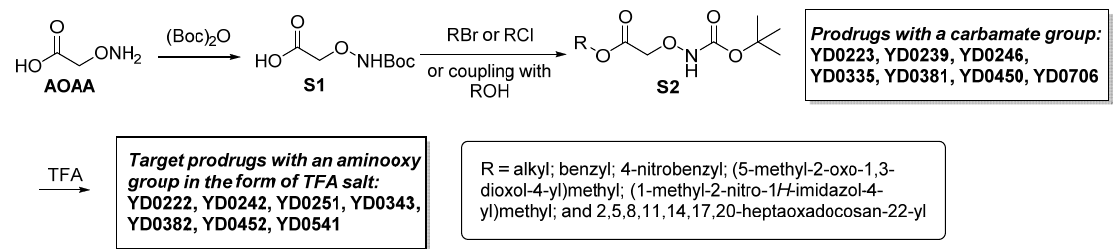
Figure 1. Synthetic routes applied to synthesize novel AOAA derivative prodrugs, with structures shown in Table 1.